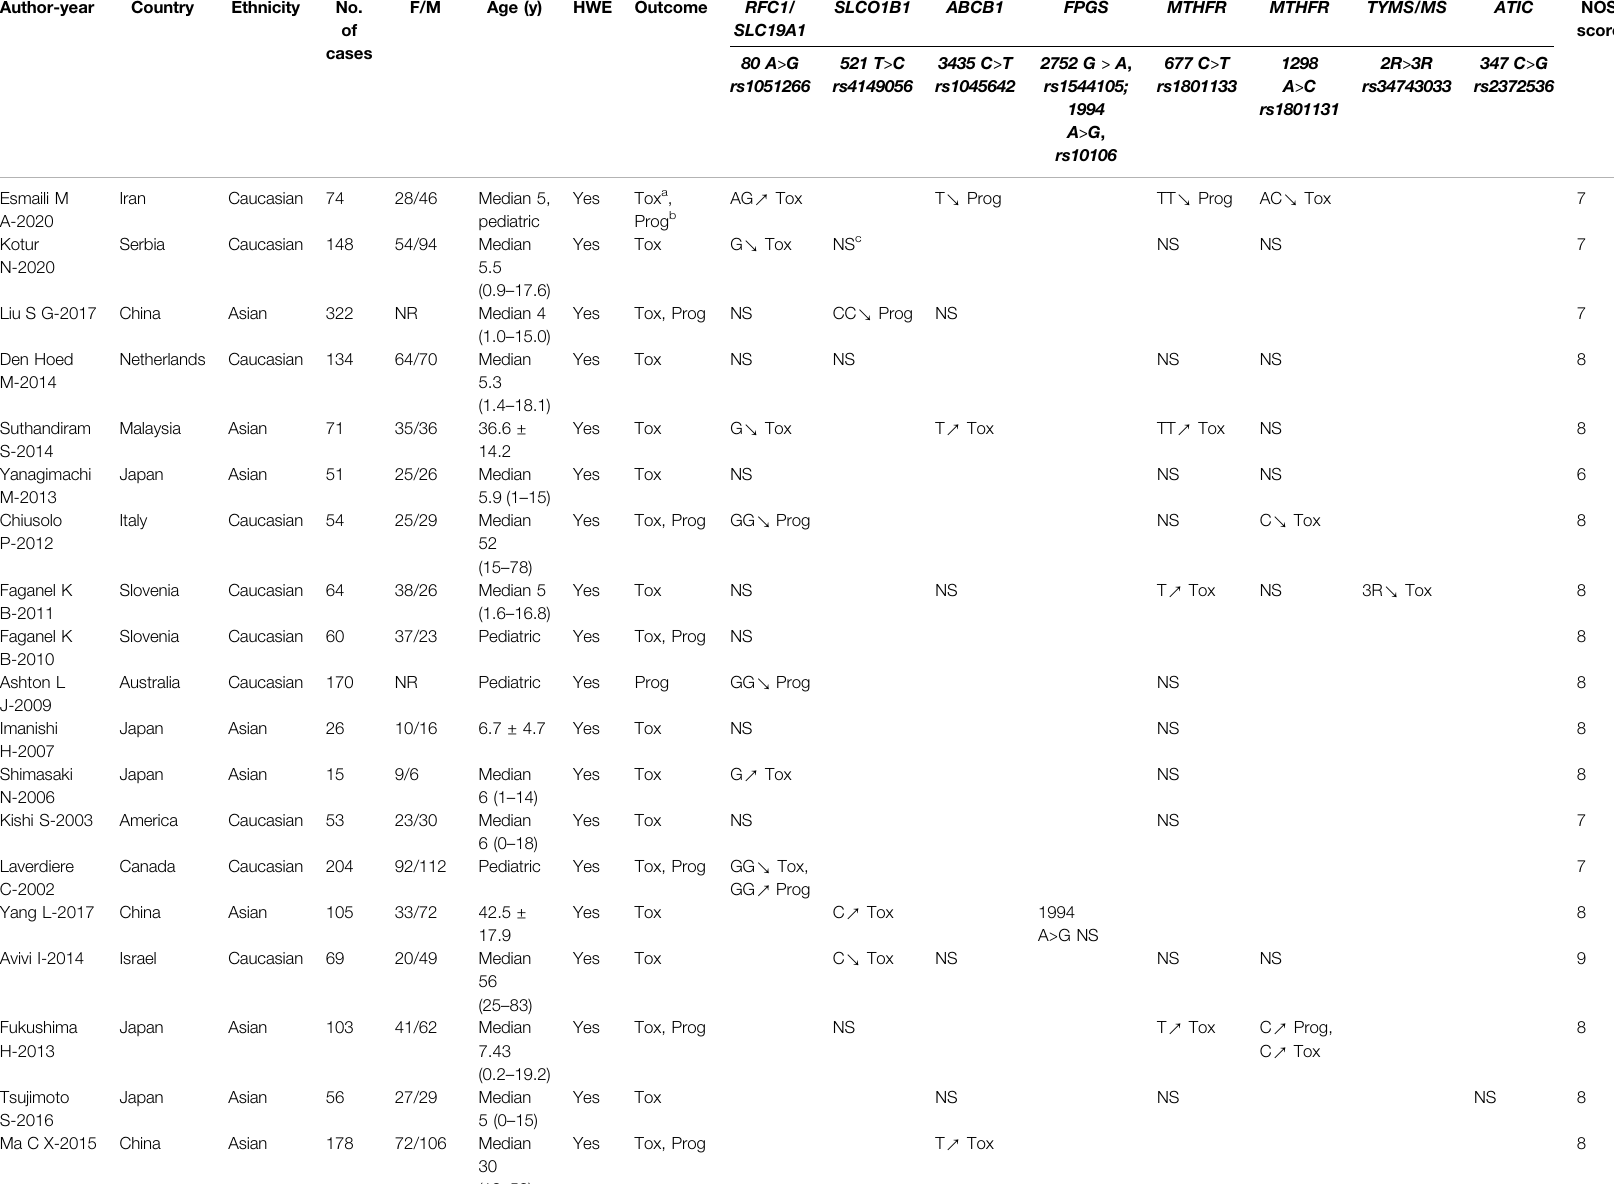
TABLE 2 | Main characteristics and NOS scores of the studies